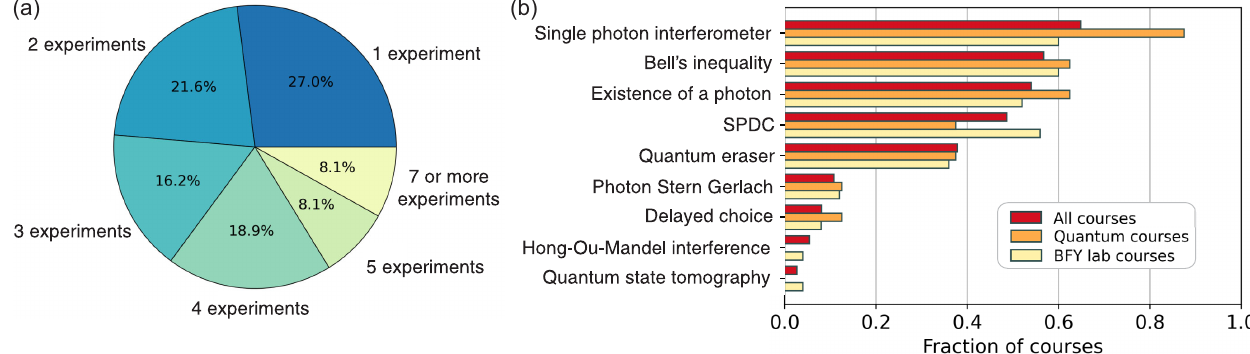
FIG. 2. (a) Number of experiments used per course ( N ¼ 37 ). (b) Fraction of all courses (red, N ¼ 37 ), quantum courses (orange, N ¼ 8